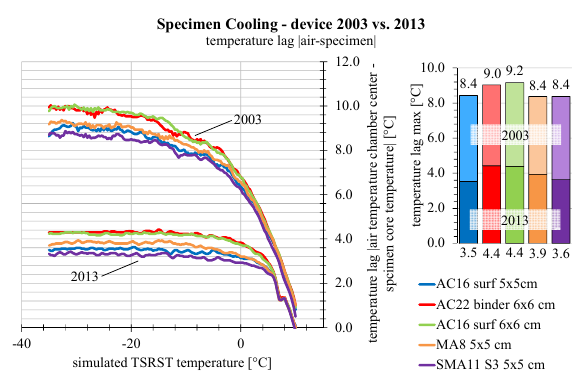
Figure 5. Temperature lag between specimen core and air temperature for both devices.